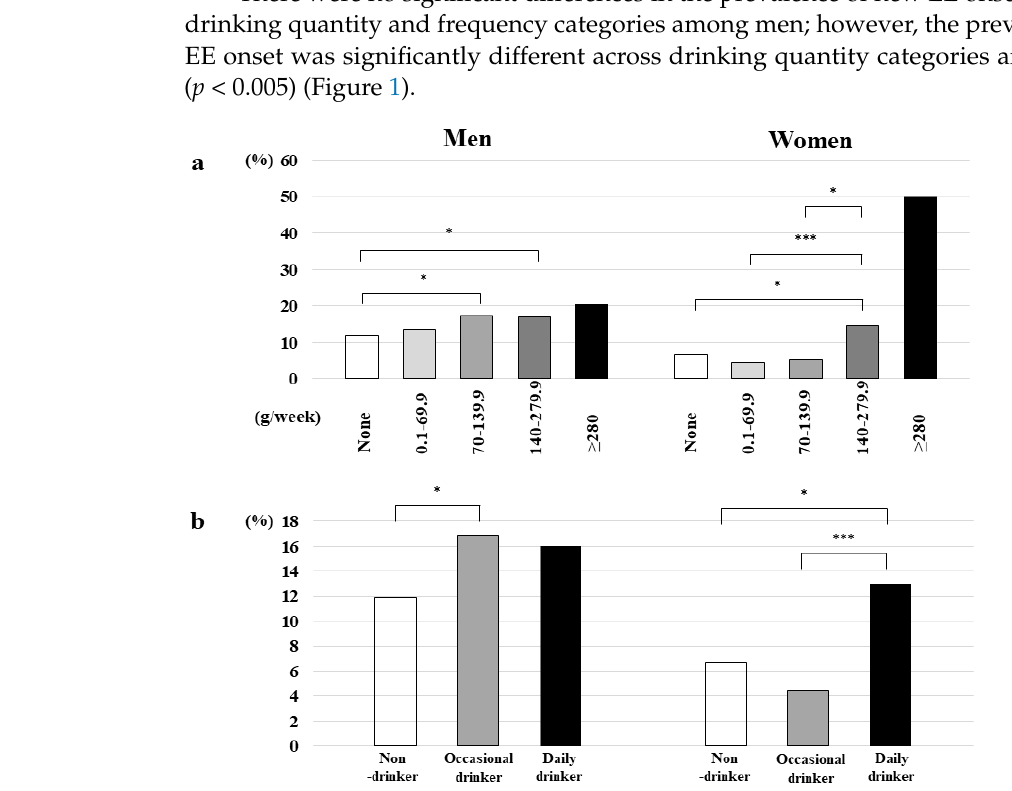
Figure 1. ( a ) Prevalence of new EE onset according to drinking quantity categories and sex. * p < 0.05, *** p < 0.005. EE, erosive esophagitis. ( b ) Prevalence of new EE onset according to drinking frequency categories and sex. * p < 0.05, *** p < 0.005. EE, erosive esophagitis.